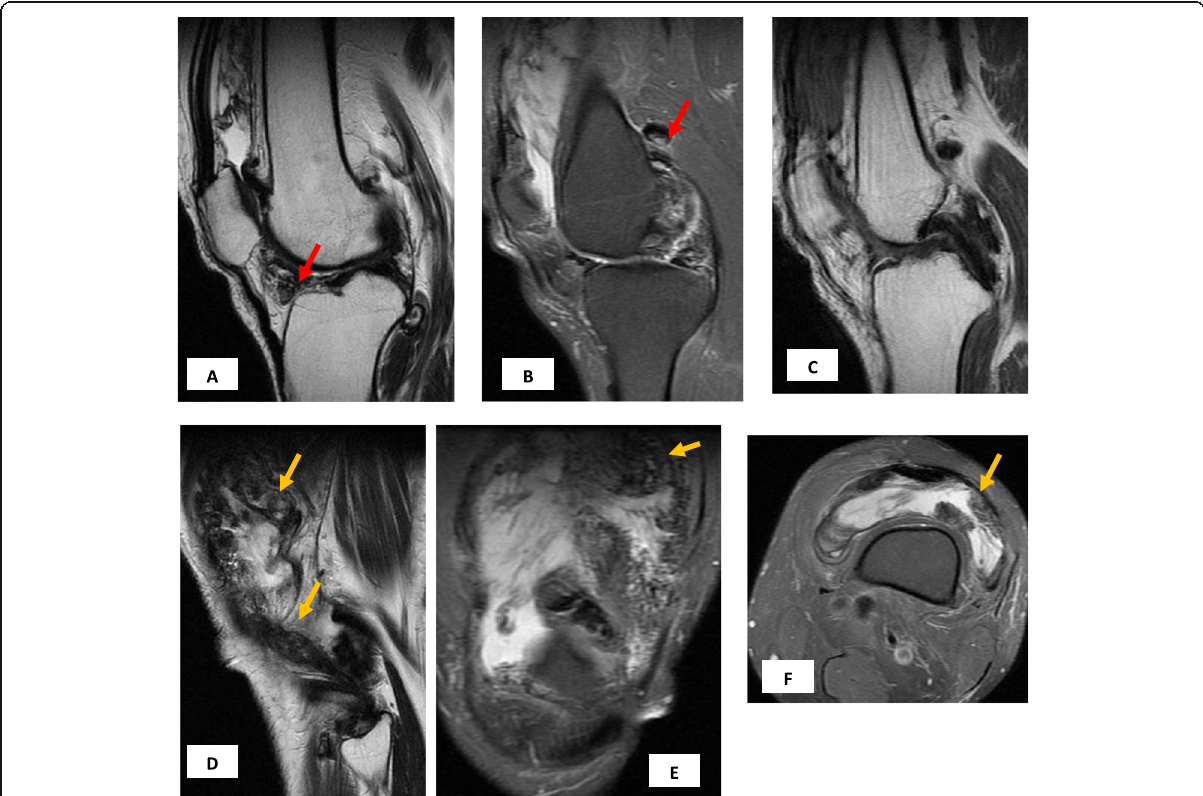
Fig. 8 Right knee synovial chondrosarcoma in 58-year-old male. Sagittal T2 ( a , d ), sagittal STIR ( b ), sagittal T1 ( c ), coronal STIR ( e ), and axial STIR ( f ) show unequal size low signal nodules at all series (red arrow) with synovial heterogeneous thickening (yellow arrows), MRI shows the possibility of synovial chondromatosis but arthroscopy reveals synovial